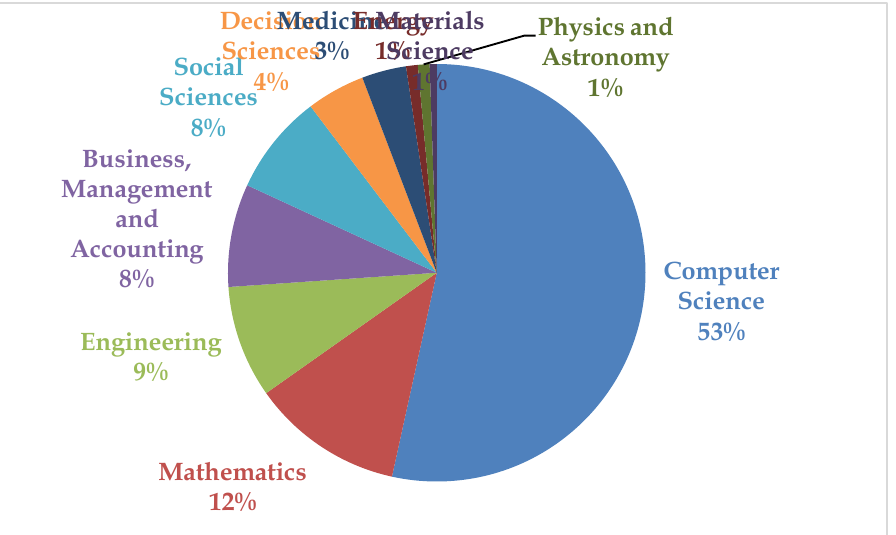
Figure 5: Document by Subject Area. Source: Scopus database.